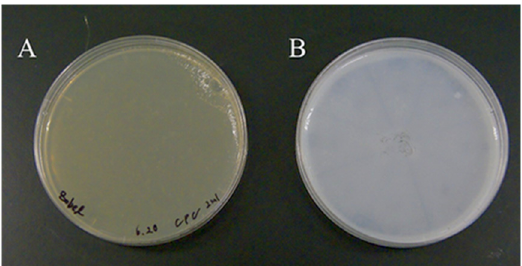
Figure 1. CPC reaction with ulvan. To identify ulvan degradation, 2 mL of 5% CPC solution was added dropwise to the Marine agar plates with and without 0.5% ulvan ( A , Marine agar medium; B , Marine agar medium with 0.5% ulvan). ( A ) No change in color was observed; ( B ) the appearance of a white color indicated presence of ulvan. Ulvan-degrading activity cannot be indicated on such a test plate without bacteria. Instead, ulvan-degrading activity was indicated by formation of a clear zone around a colony that was able to degrade ulvan.